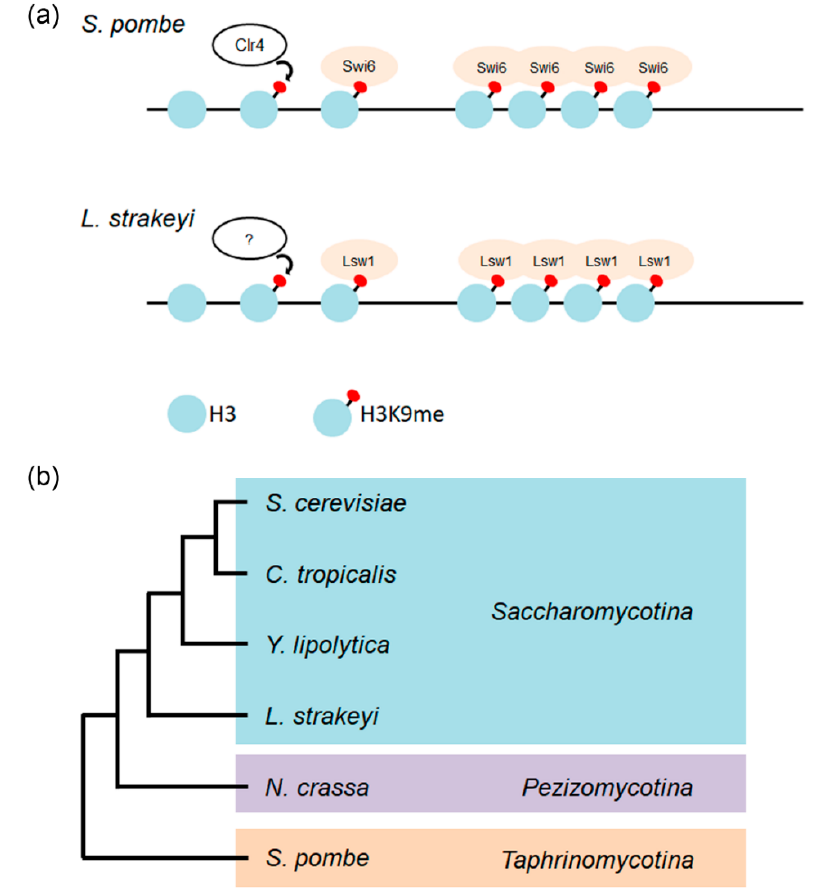
Figure 9. Heterochromatin formation. ( a ) Schematic of heterochromatinization of S. pombe (upper) and corresponding putative heterochromatinization of L. starkeyi (lower). ( b ) An evolutionary tree showing the relationship among yeasts. Phylogenetic tree based on [2,48] .